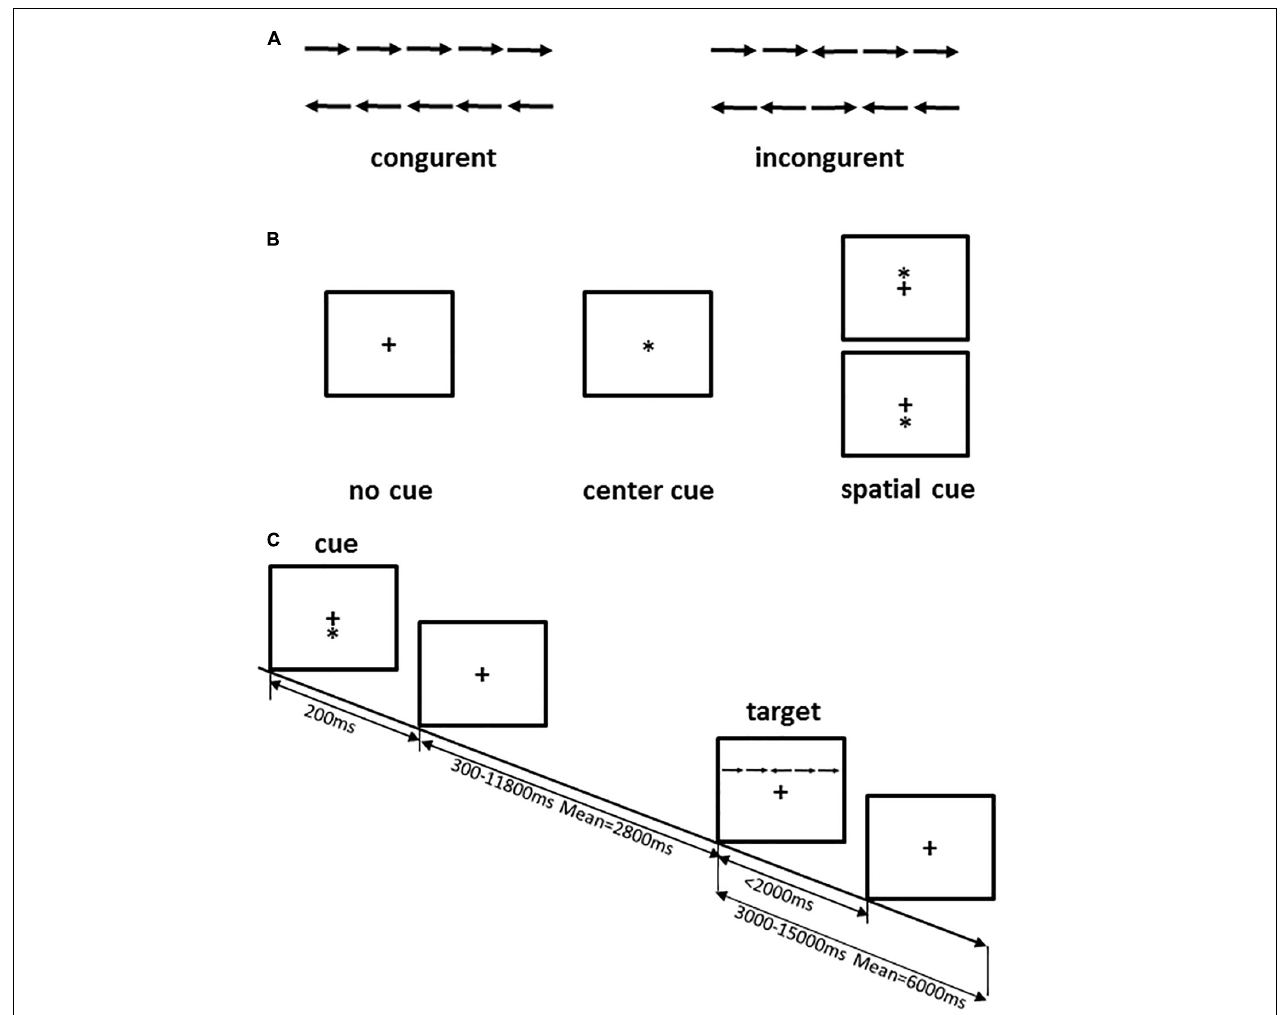
FIGURE 2 | ANT procedure. (A) The four stimuli used in the present test; (B) the three cue conditions; (C) an example of the procedure. Adapted from Jin et al. (2005).